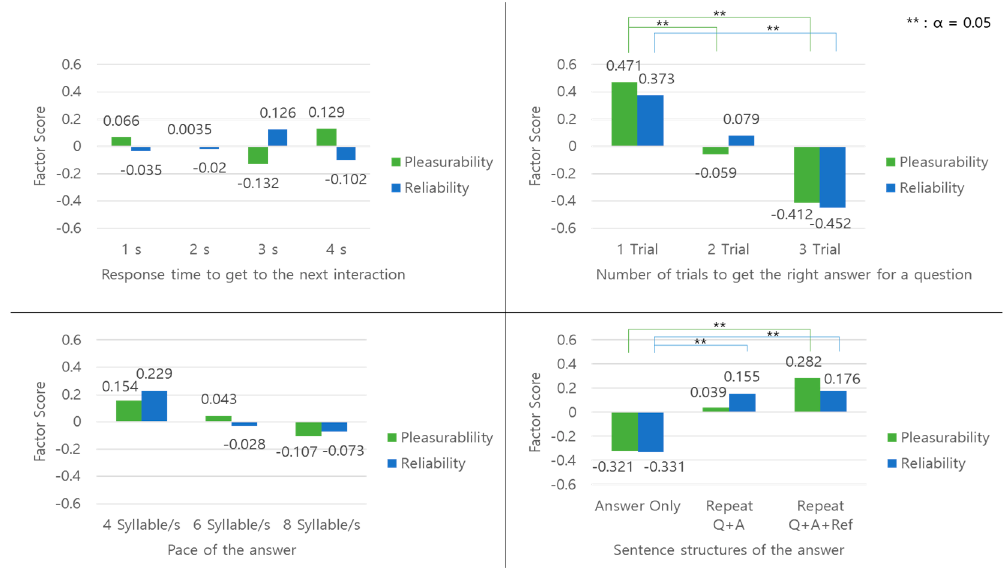
Figure 4. Emotional factor scores obtained using ANOVA for different voice-based intelligent system design parameters.